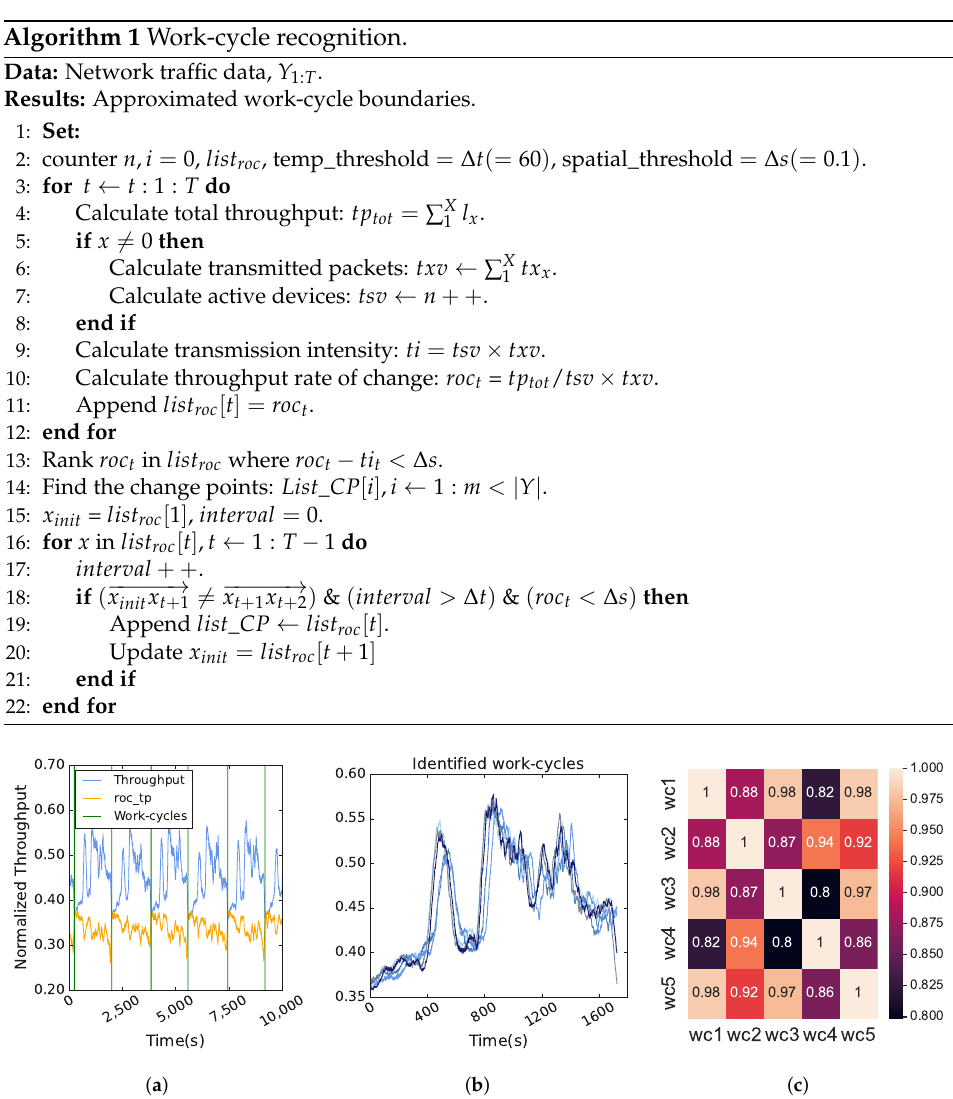
Figure 3. The work-cycles recognition is realised through: deploying communication intensity parameters to find work-cycles boundaries ( a ); the non-overlapping segments resemble similar repeated patterns ( b ); the Spearman’s correlation shows high degree of similarity between the identified work-cycles ( c